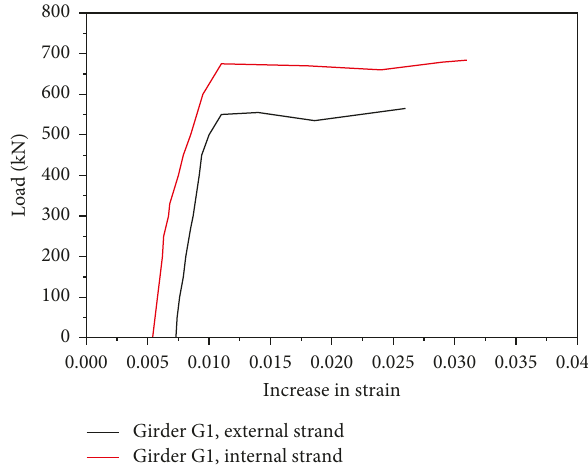
Figure 11: Increase of strain in prestressing strands of girders G1 and P1.